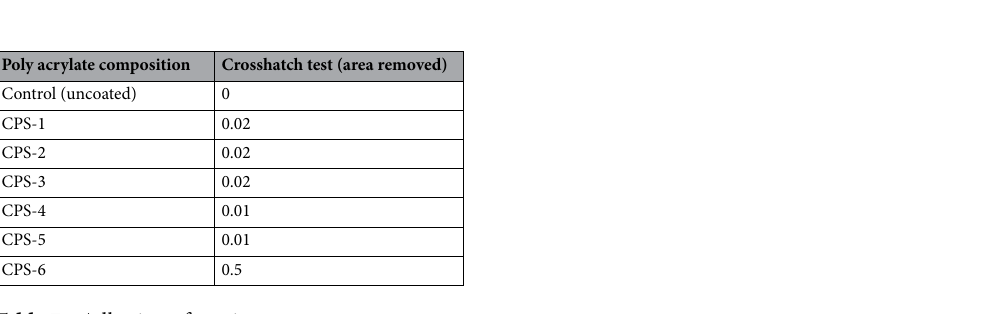
Table 7. Adhesion of